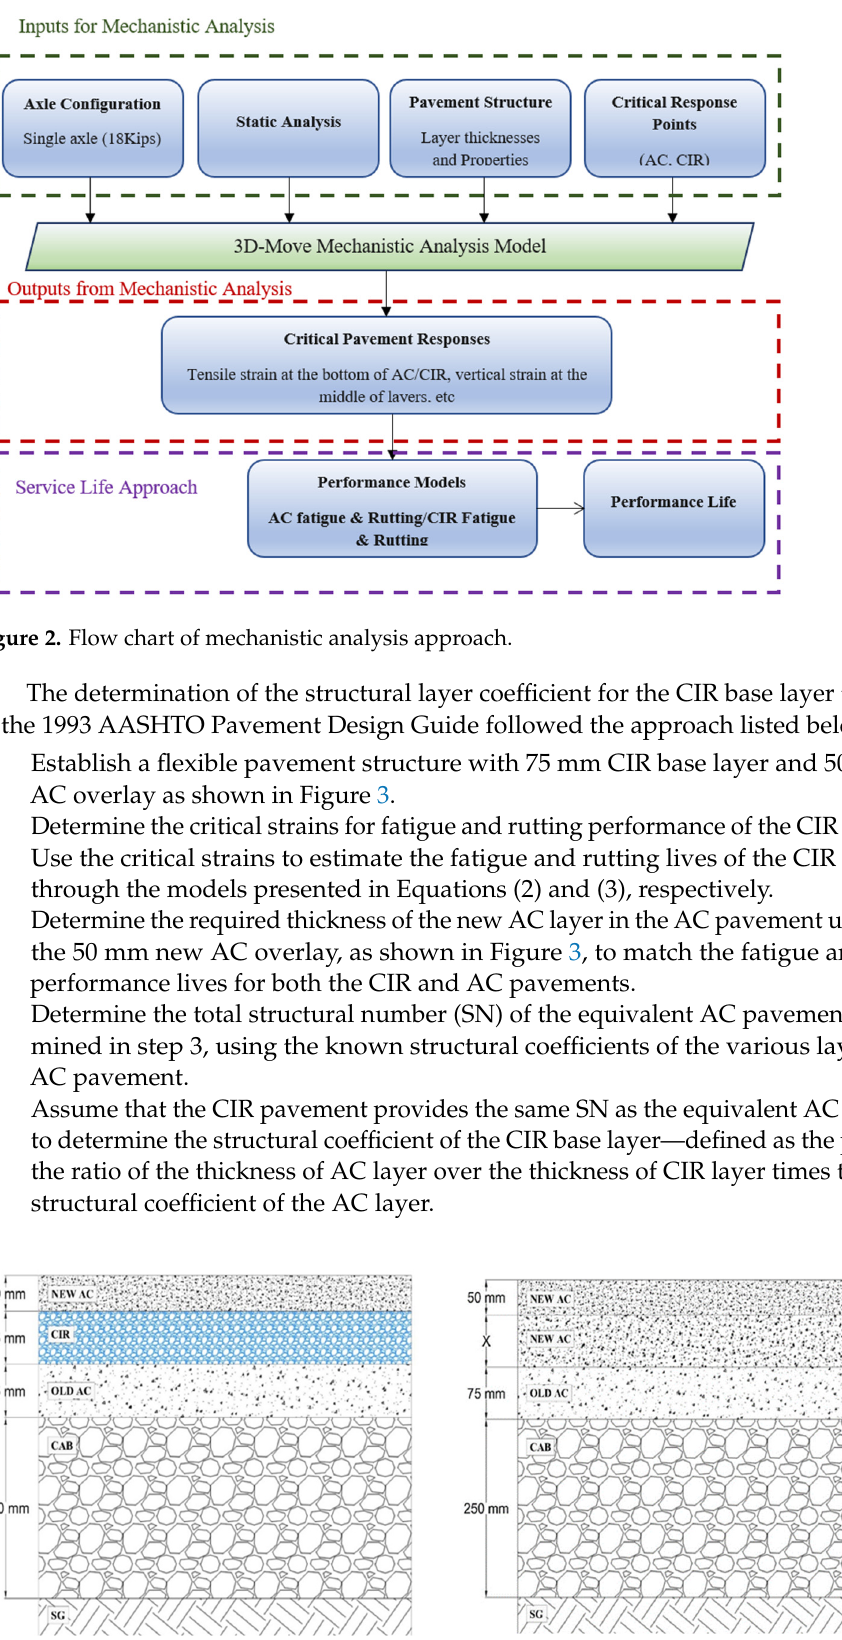
Figure 3. Flexible pavement structures using CIR and AC layers.